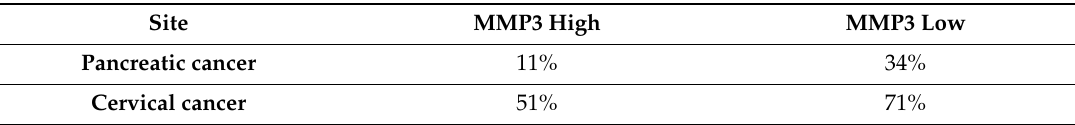
Table 5. Five-year survival in MMP3-high vs. -low expression groups.